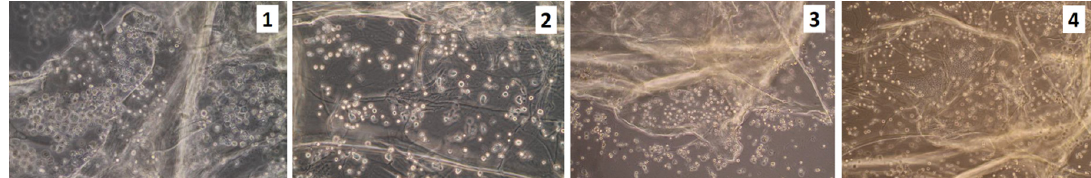
Figure 14. Unsterilized scaffolds coated with fibronectin (100 ng/1 mL), rinsed in the high volume of PBS containing antibiotics; 3rd of the cell culture . (sample 1—chitosan crosslinked with adipic and malonic acid; sample 2—chitosan crosslinked with adipic and L -glutamic acid; sample 3—chitosan crosslinked with adipic, L -glutamic and malonic acid; sample 4—chitosan crosslinked with adipic and levulinic).